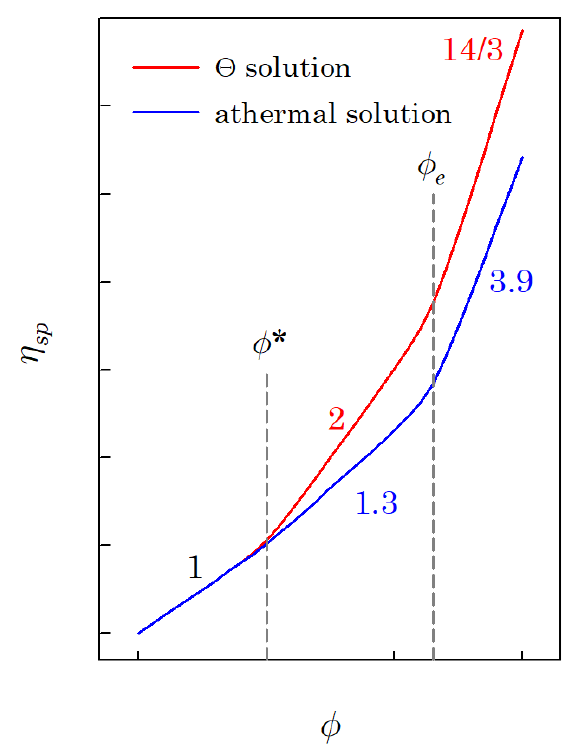
Figure 1. A schematic diagram for specific viscosity of the polymer solution as a function of polymer volume fraction (logarithmic scales).